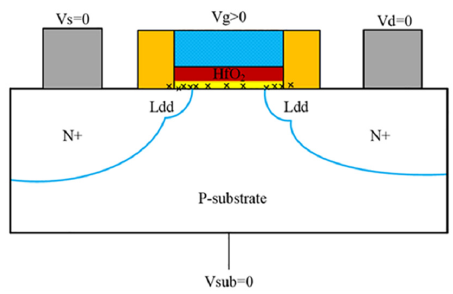
Figure 14. Schematic diagram of damage to the device non ‐ uniformly distributed along the channel.